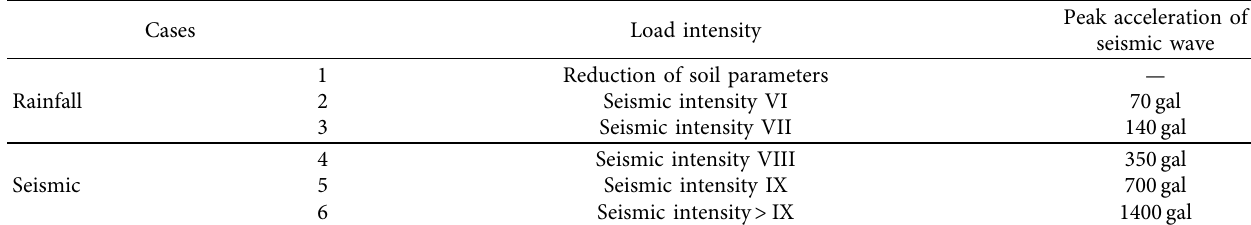
Table 3: Calculation